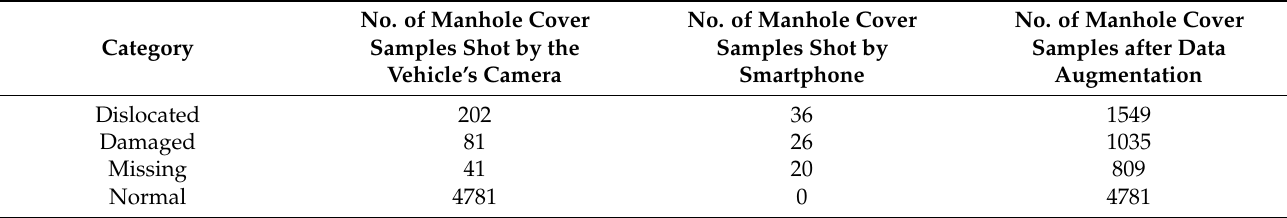
Figure 6. Examples of VGCopy ‐ paste. Table 2. Classification of manhole covers and the quantity of various covers collected. Category